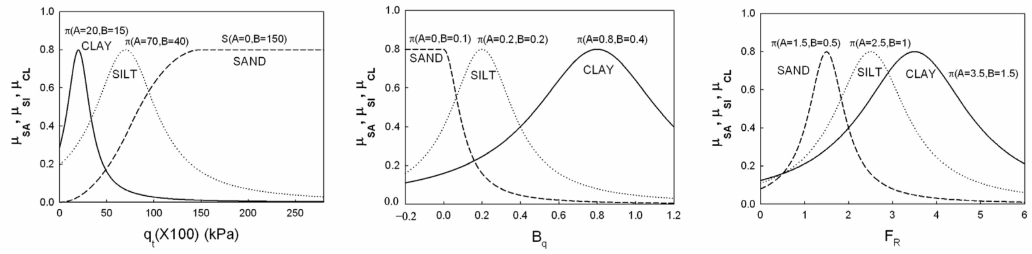
Figure 2. Fuzzy membership functions of soil sets for three parameters, q t , F r , and B q . Three soil fuzzy sets for clay, silt, and sand were named CL, SI, and SA, as defined in Equation (4). µ CL , µ SI , and µ SA represent the summation of membership function values from each chart for clay, silt, and sand,